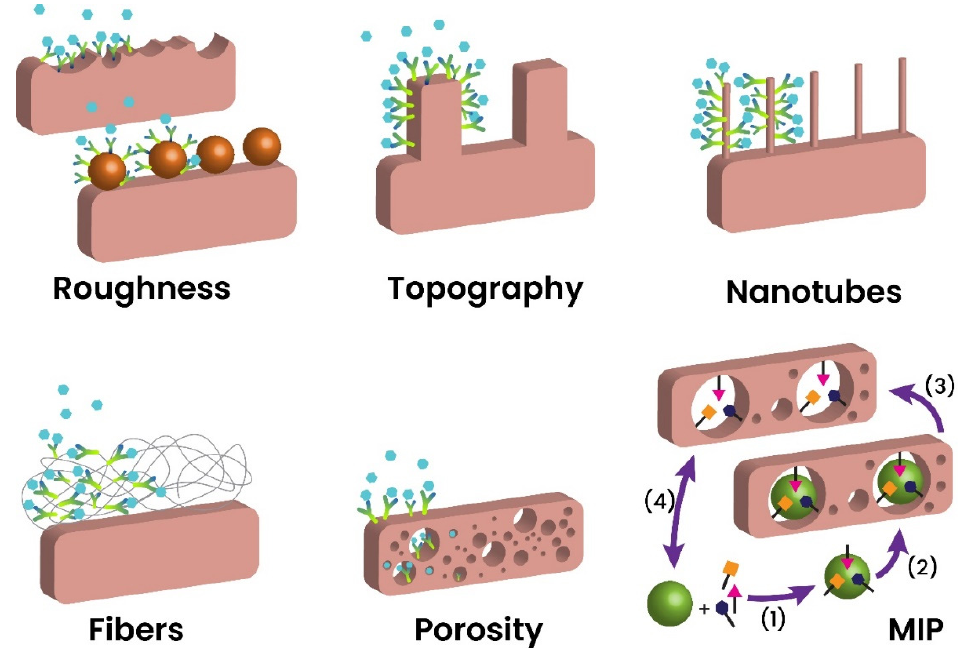
Figure 2. Typical 3D architectures used in biosensors, including roughness enhancement, topo ‐ graphical structures, fiber networks, etc. Molecularly imprinted polymers can be used in four steps: Assembly (1), deposition and polymerization (2), removal (3), and back to the initial step (4). Adapted with permission from Ref. [169] . ©2019, Elsevier B.V.